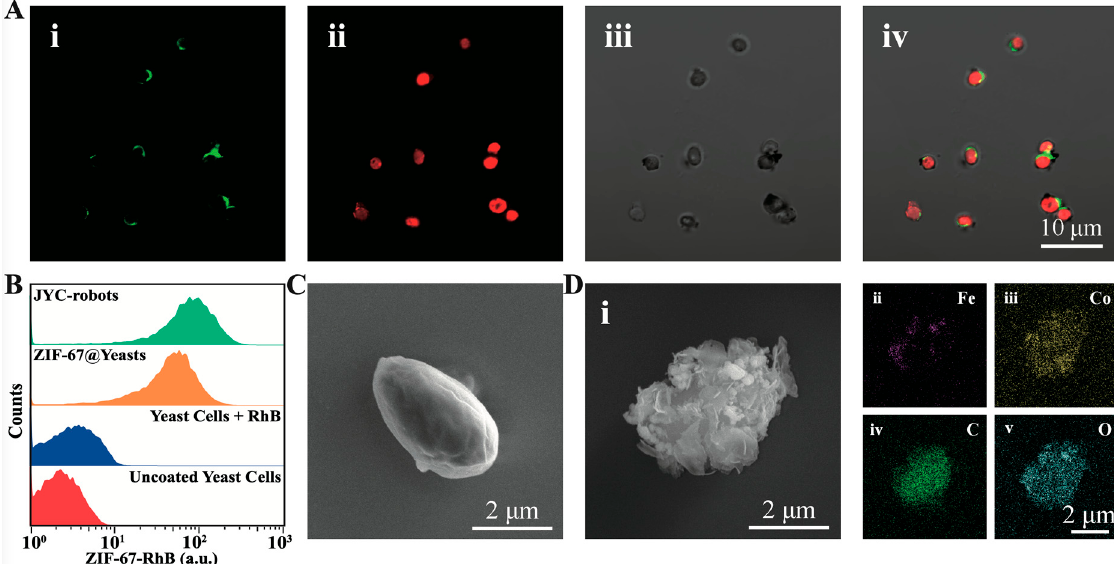
Figure 2. Characterization of JYC-robots. ( A ) CLSM images of JYC-robots: i: FITC channel; ii: RhB channel; iii: bright-field channel, iv: merged image of FITC, RhB, and bright-field channels. ( B ) Representative flow cytometry histograms of JYC-robots (cyan), ZIF-67@Yeasts (orange), yeast cells mixed with RhB (blue), and uncoated yeast cells (red). ( C ) SEM image of uncoated yeast cells. ( D ) SEM and corresponding EDX images of the JYC-robot.